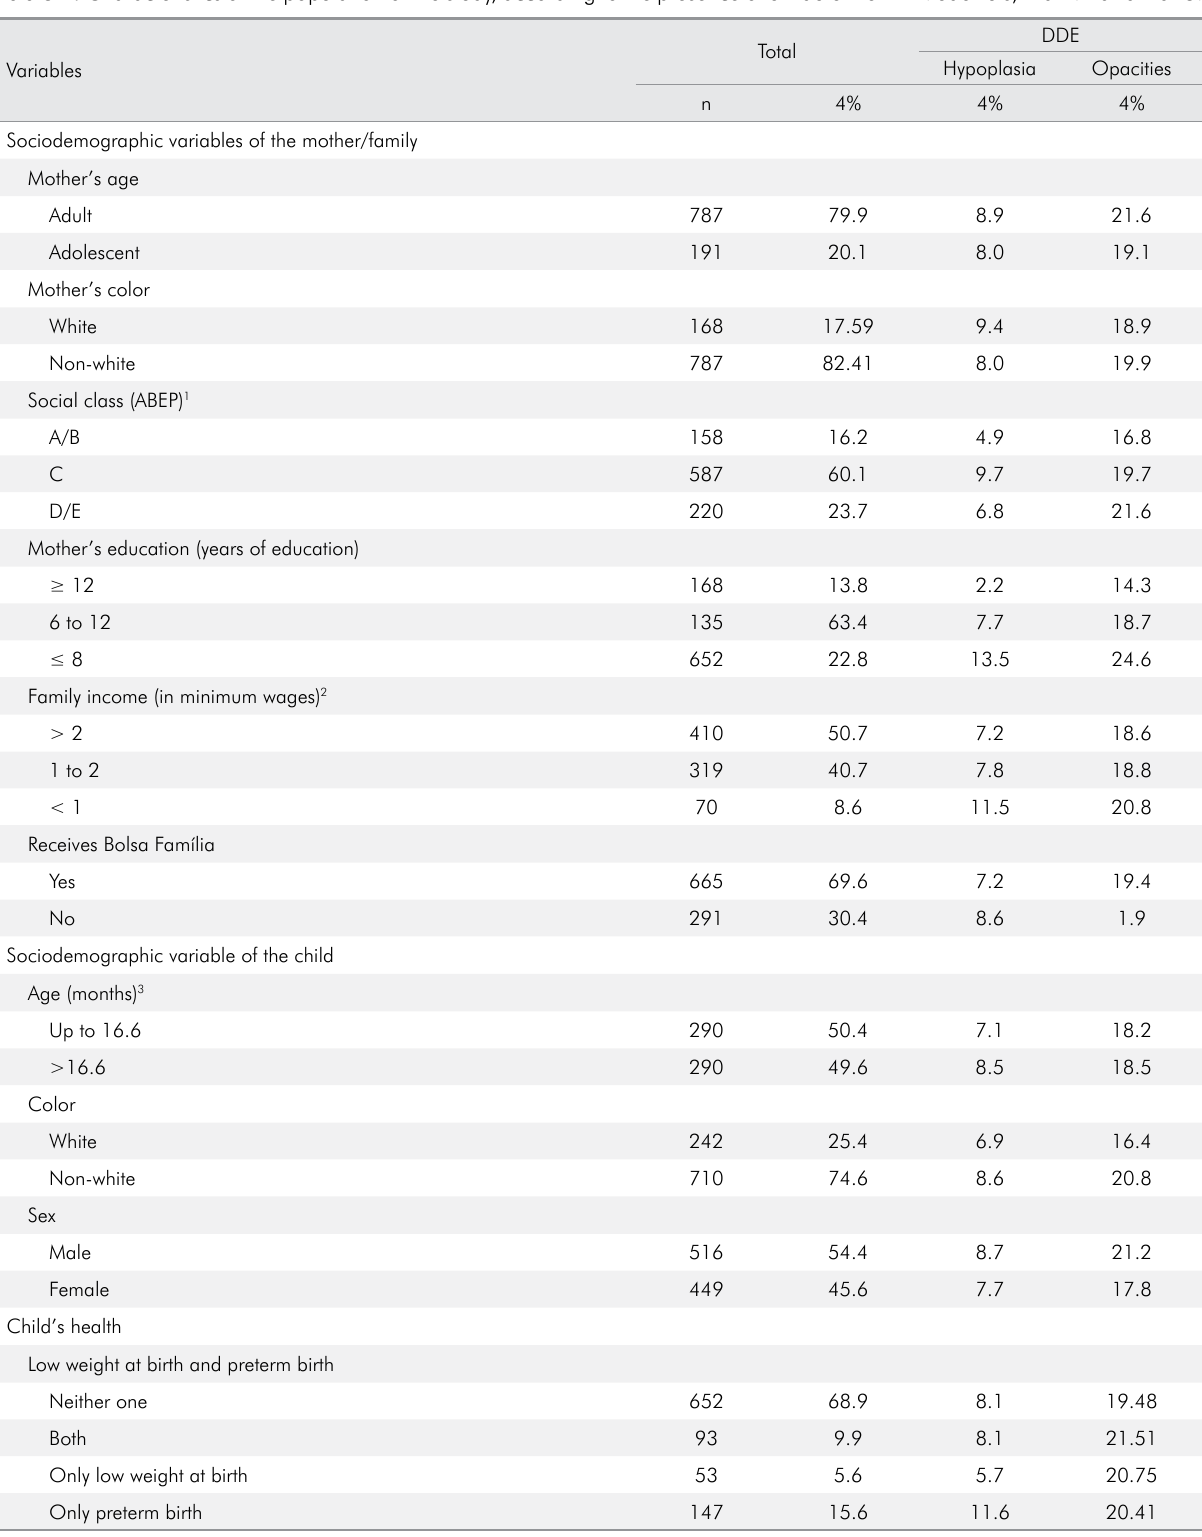
Table 2. Characteristics of the population of the study, according to the presence of extrauterine DDE. São Luís, Brazil. 2010-2013.